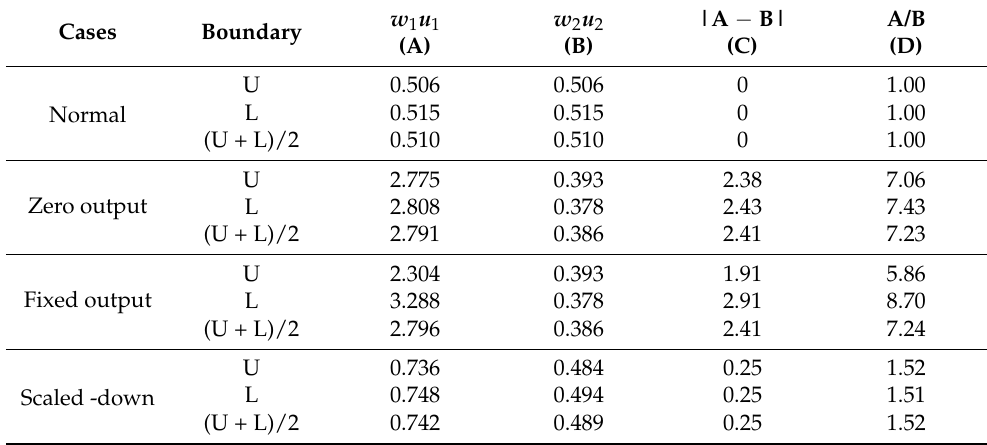
Table 2. Modulated control signals and pattern variations when Motor 1 is faulty.